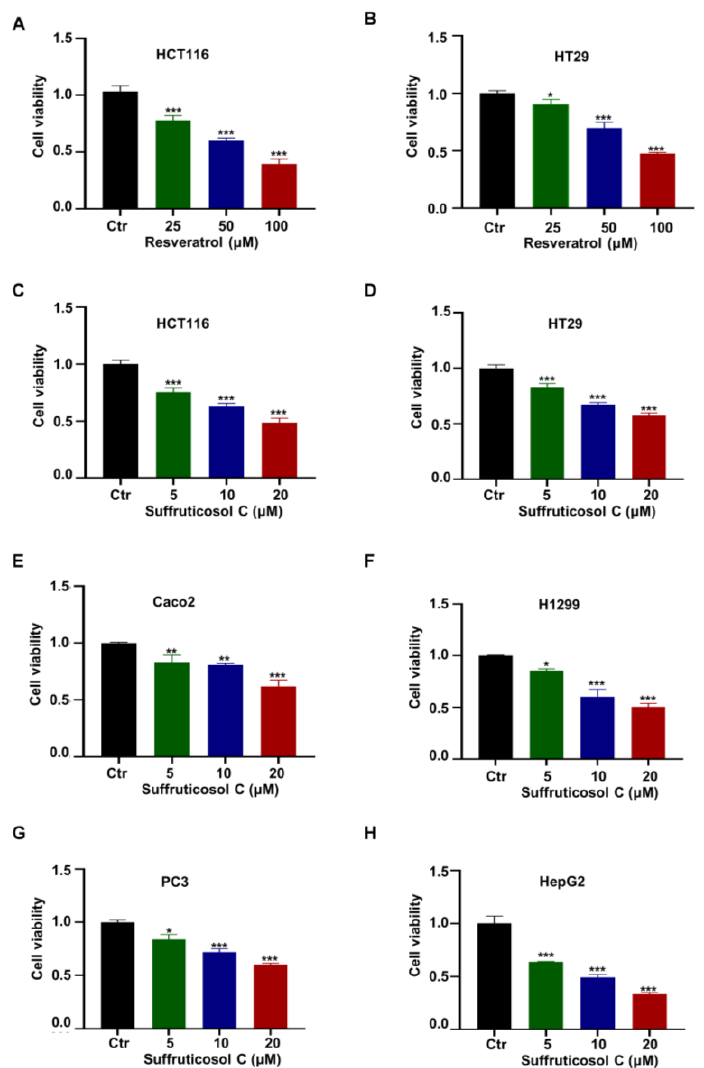
Figure 1. Effect of suffruticosol C and resveratrol on the growth of various cancer cells. HCT116 ( A ) and HT29 ( B ) cells were treated with different concentrations of resveratrol for 72 h, and the viability of cells was detected by CCK-8. HCT116 ( C ), HT29 ( D ), Caco2 ( E ), H1299 ( F ), PC3 ( G ), and HepG2 ( H ) cells were treated with different concentrations of suffruticosol C for 72 h, and the viability of cells was detected by CCK-8. All samples were normalized to cell number and conducted with three independent replicates. Data were analyzed by one-way ANOVA ( A – H ) were expressed as Mean ± SD ( A – H ). Different colors represent the different concentration of resveratrol or suffruticosol C. *, p < 0.05; **, p < 0.01; ***, p < 0.001. Ctr: normal control